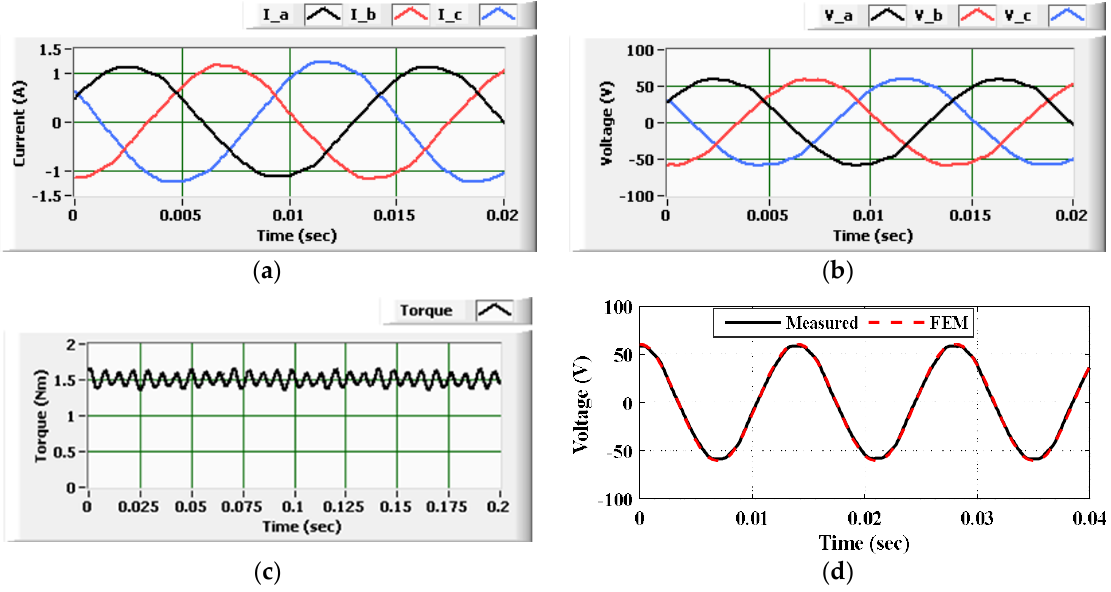
Figure 14. The experimental results under loading as a generator. ( a ) The waveform of phases’ currents; ( b ) the waveform of phases’ voltages; ( c ) the electromagnetic torque; ( d ) the measured and FE-predicted phase voltage.